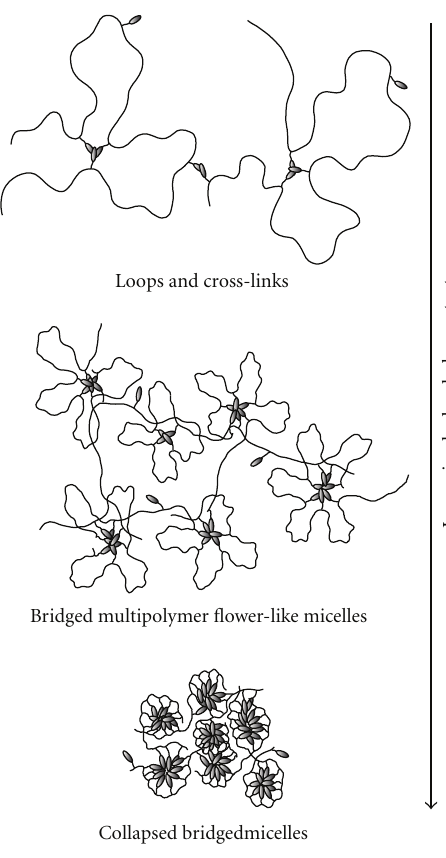
Figure 4: Inter- plus intrapolymer association.